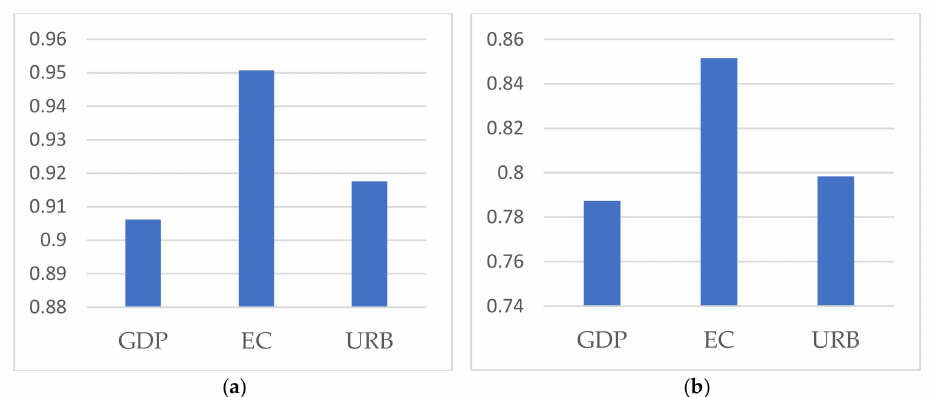
Figure 7. The partial correlation coefficient between CO 2 emissions and each input variable: ( a ) partial Spearman’s rank correlation; ( b ) partial Kendall’s rank